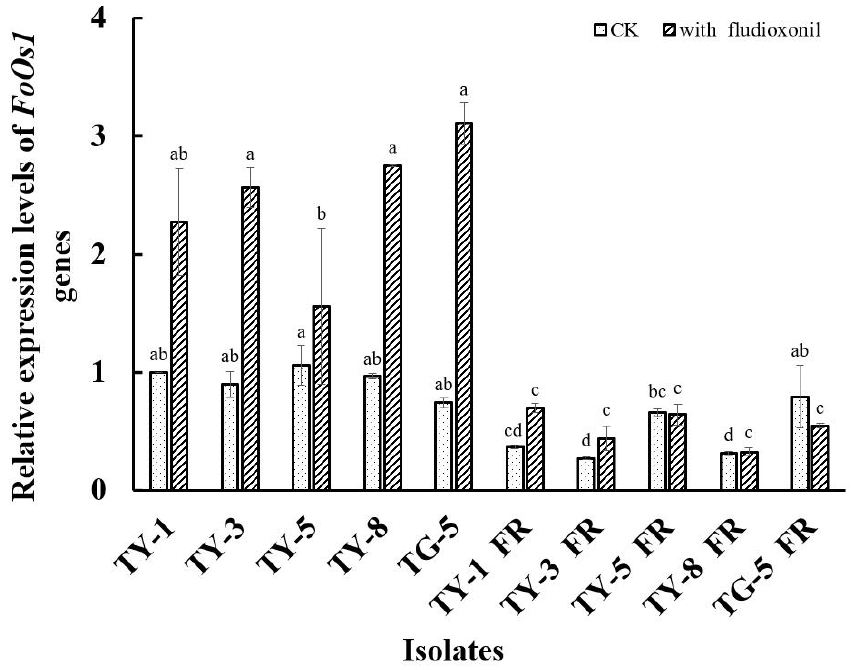
Figure 4. Relative expression of the FoOs1 gene in five fludioxonil-resistant mutants (TY-1-fR, TY-3-fR, TY-5-fR, TY-8-fR, and TG-5-fR) of FOM and their sensitive parental isolates (TY-1, TY-3, TY-5, TY-8, and TG-5) in the absence and presence of fludioxonil. Data are the means of three replicates ± SE. Error bars indicate one standard error of the mean (SE) as calculated from the mean of two separate experiments, while different letters above columns indicate significant differences according to Fisher’s least significant difference test ( p ≤ 0.05). CK indicates the expression level in the absence of fludioxonil.